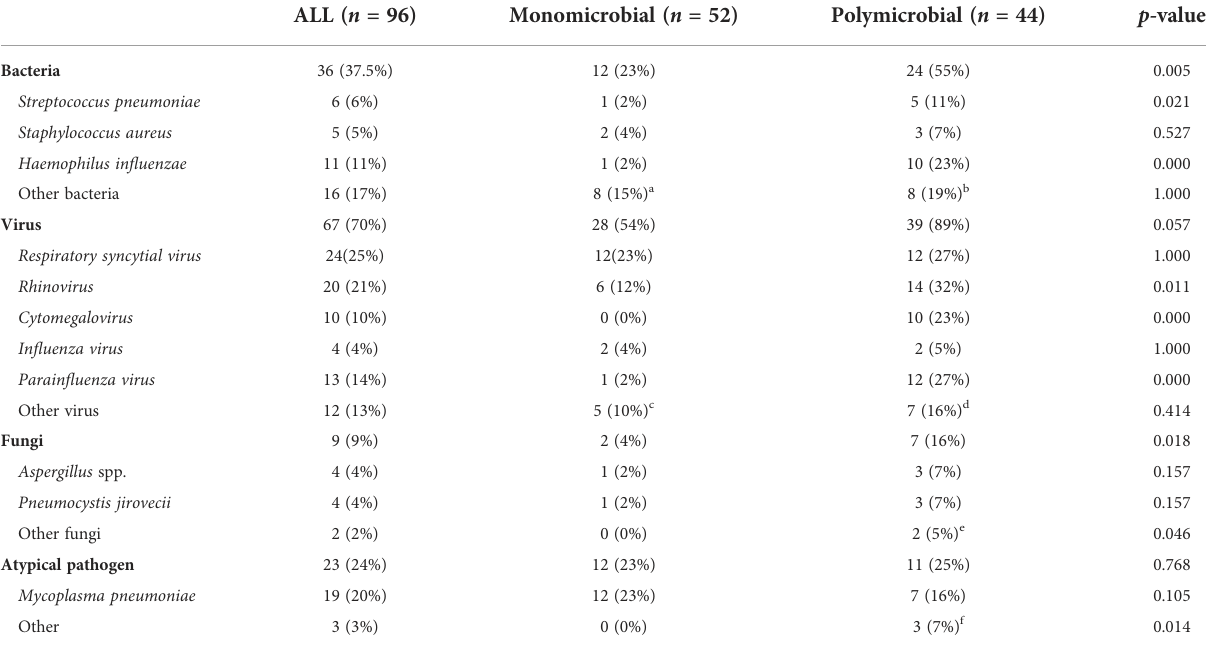
TABLE 2 Pneumonia pathogens in 96 patients.